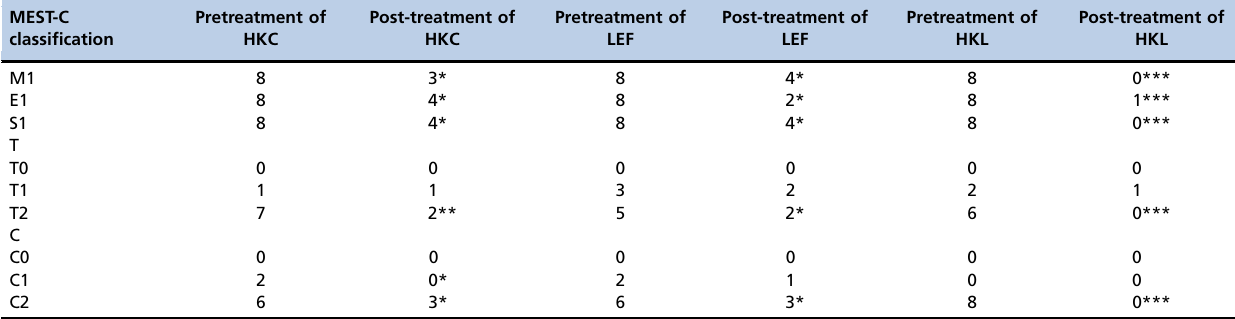
Table 1 - Comparison of pathological examination results before and after drug treatment [n (%)]. MEST-C Pretreatment of Post-treatment of classification HKC HKC